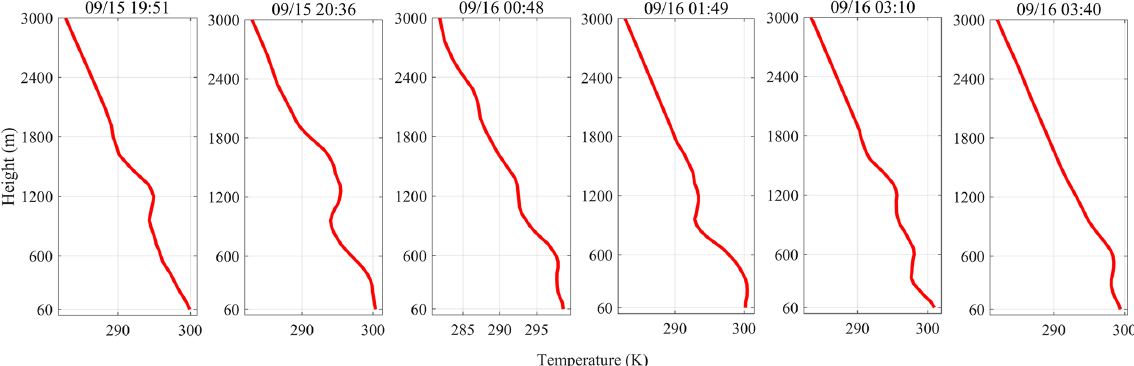
Figure 15. Temperature profiles from the evening of 15 September 2019 to the early hours of 16 September 2019.